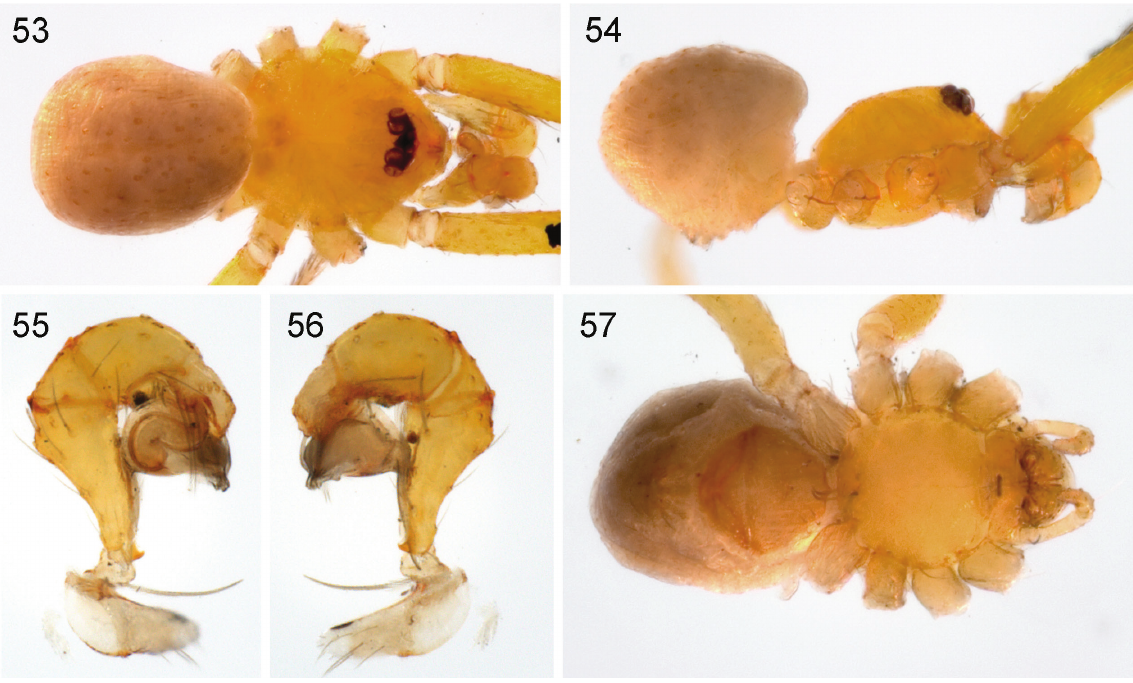
Figs 53-57. Ninetis faro sp. nov. 53-54 . ♂, dorsal and lateral views. 55-56 . Left ♂ palp, prolateral and retrolateral views. 57 . ♀, ventral